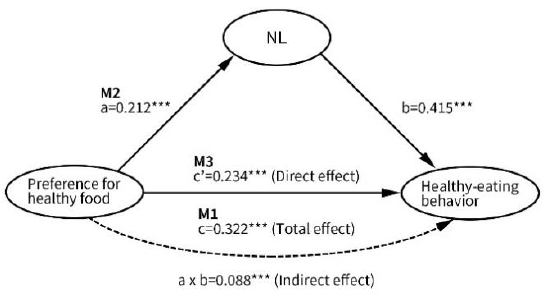
Figure 1. A graphical example of the mediating effect of NL, (*** p < 0.001).